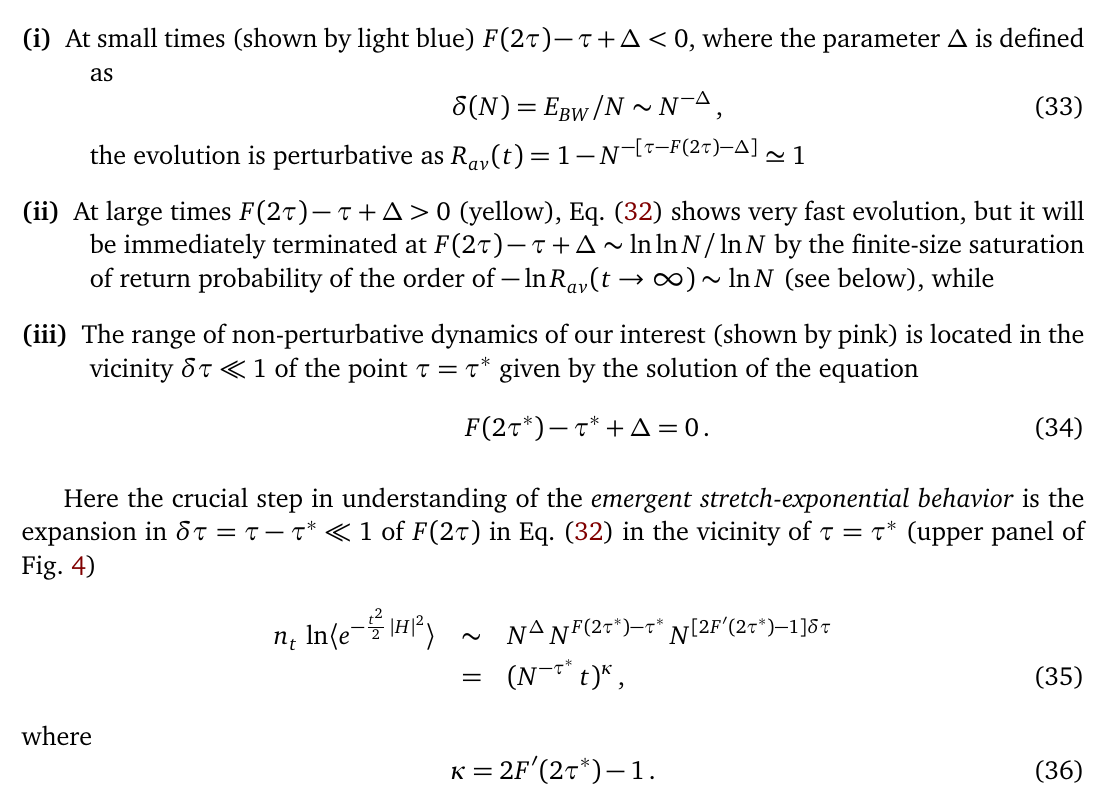
Figure 4: (Color online) Emergent stretch-exponential dynamics in the MF-RP ensemble . The dynamics of return probability given by Eq. (32) is divided into three regions: (blue) where the exponent in Eq. (32) is negative and R c > 0; (yellow) where the exponent is positive but Eq. (32) loses its validity due to ( t ) (cid:39) N − D 2 which is beyond WW approach, and (pink) the the saturation of R av